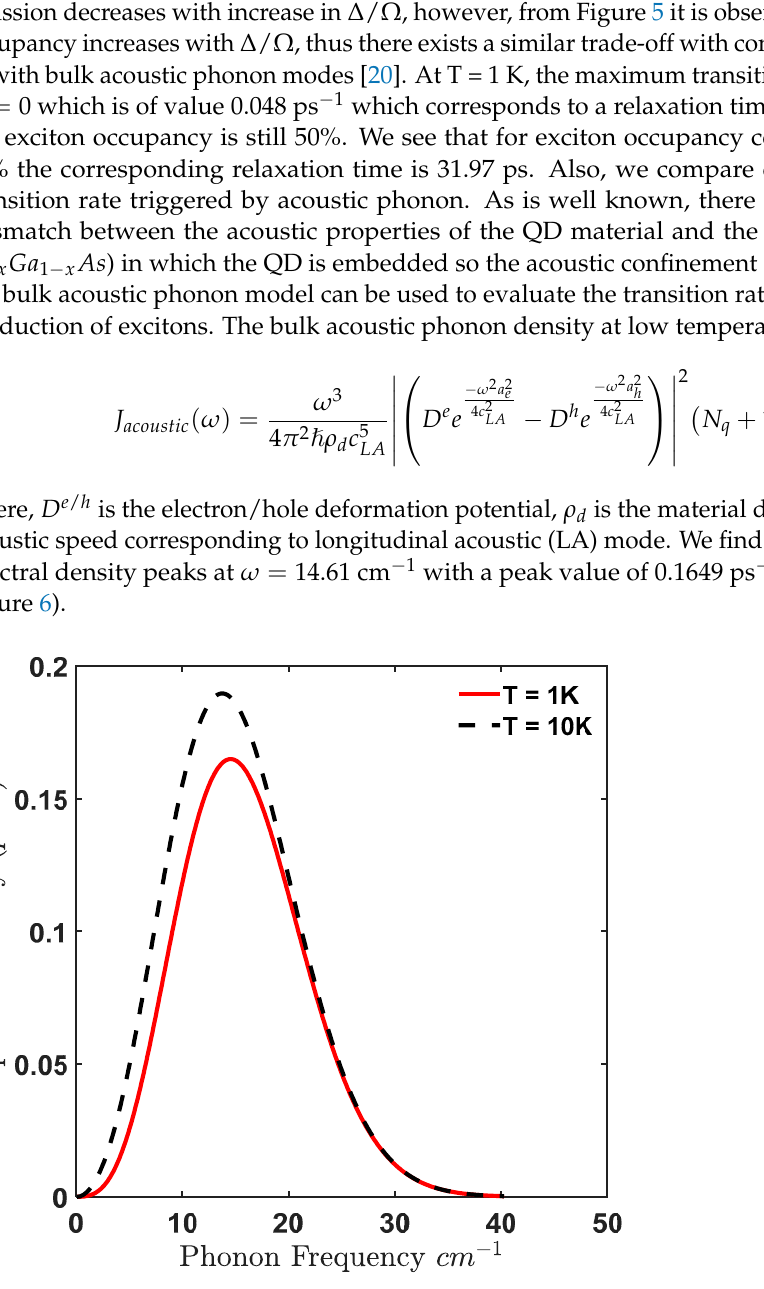
Figure 6. Bulk acoustic phonon spectral density in GaAs at T = 1 K (red) and T = 10 K (black dashed). Using this value in Equation (30), we find the maximum transition rate for acoustic phonon as a function of ∆ / Ω in Figure 5 (black dashed): Corresponding to an exciton occupancy of 80%, the relaxation time for acoustic phonon at T = 1 K is 5.95 ps, hence it is 5.37 times less than the confined LO mode at the same temperature. However, the average transition rate for confined LO mode for exciton occupancy above 80% for temperature T ≤ 10 K is 0.042 ps − 1 (that corresponds to relaxation time of 23.8 ps) whereas for acoustic phonon mode, the average transition rate for T ≤ 10 K is 0.24 ps − 1 (that corresponds to relaxation time of 4.17 ps). Hence, the exciton creation rate attributed to confined LO phonon is 5.7 times (~6 times) slower than acoustic phonon.